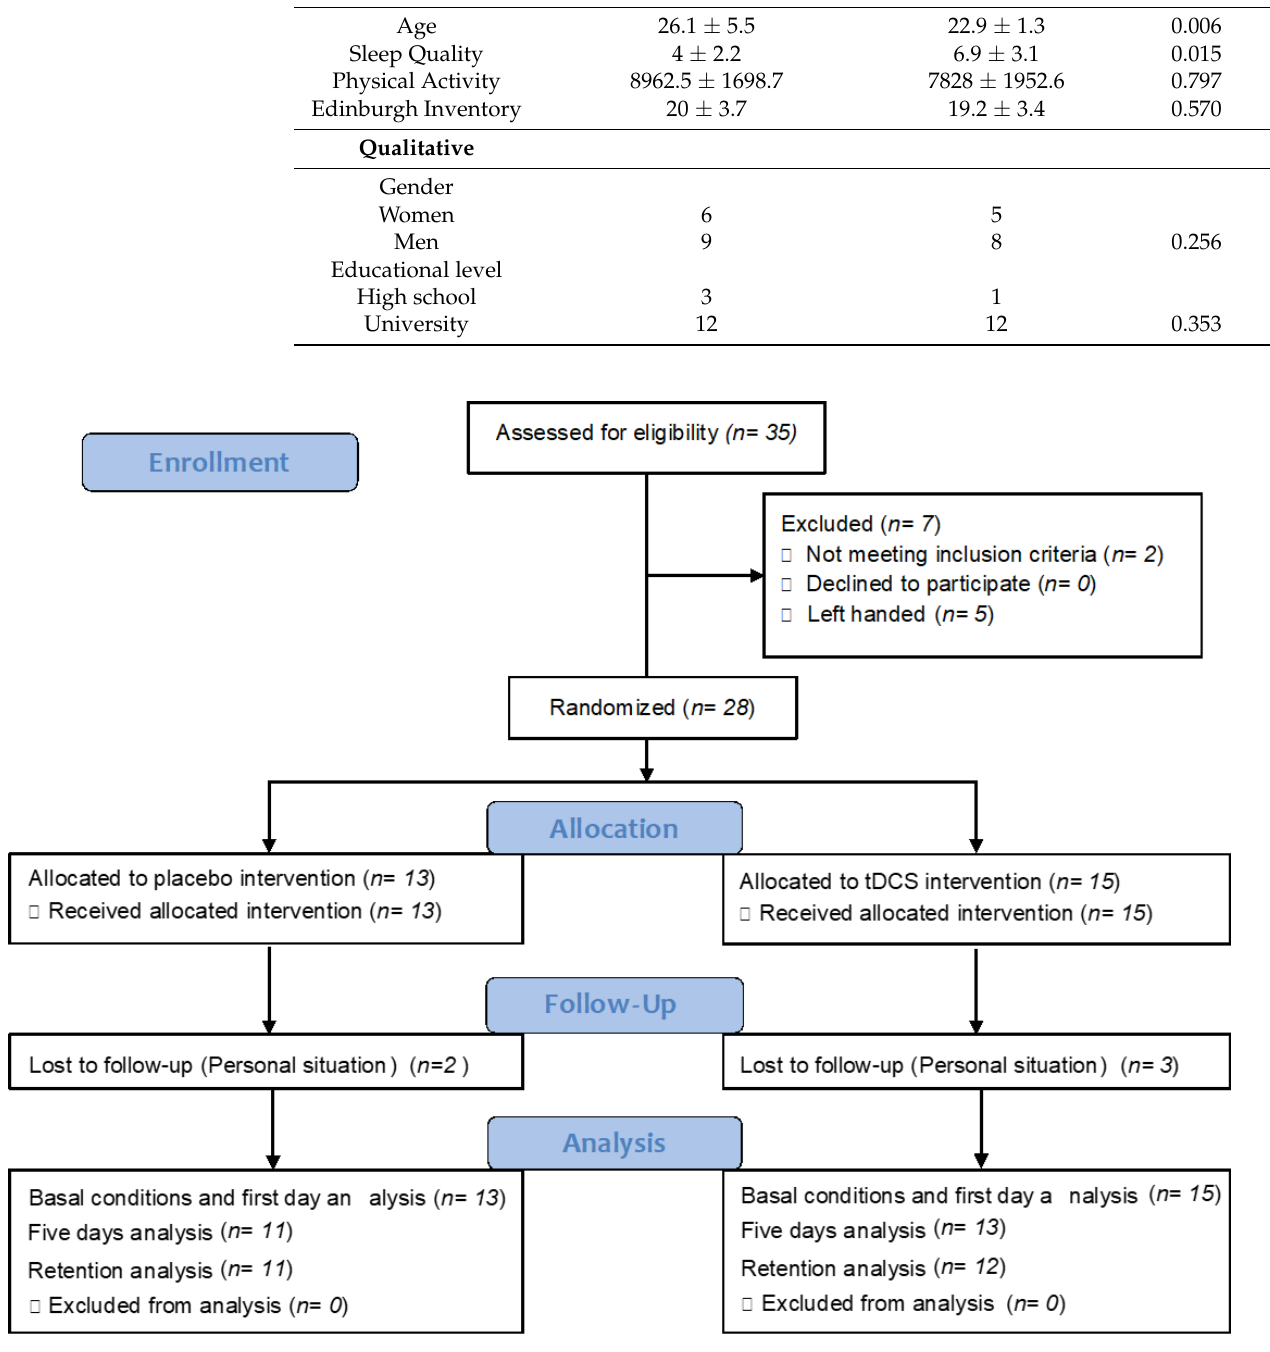
Figure 3. Flow chart of enrollment procedure according to Consort 2010 statement.